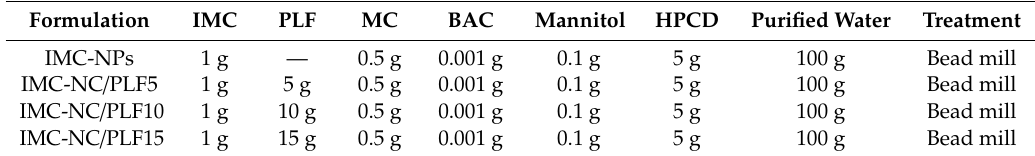
Figure 1. Particle-size frequencies and atomic force microscopy (AFM) images of indomethacin (IMC) in each ophthalmic indomethacin nanocrystal (IMC-NC) formulation. ( A – D) Particle-size frequencies of IMC in ( A ) ophthalmic dispersions containing IMC-NCs (IMC-NPs), ( B ) IMC-NCs with 5 g of Pluronic F-127 (IMC-NC / PLF5), ( C ) IMC-NC / PLF10, and ( D ) IMC-NC / PLF15. ( E ) AFM images of IMC in IMC-NPs, IMC-NC / PLF5, IMC-NC / PLF10, and IMC-NC / PLF15. Compositions of each ophthalmic IMC-NC formulation shown in Table 1. IMC particles in each ophthalmic IMC-NC formulation were 50–170 nm. Table 1. Composition of ophthalmic IMC-NC